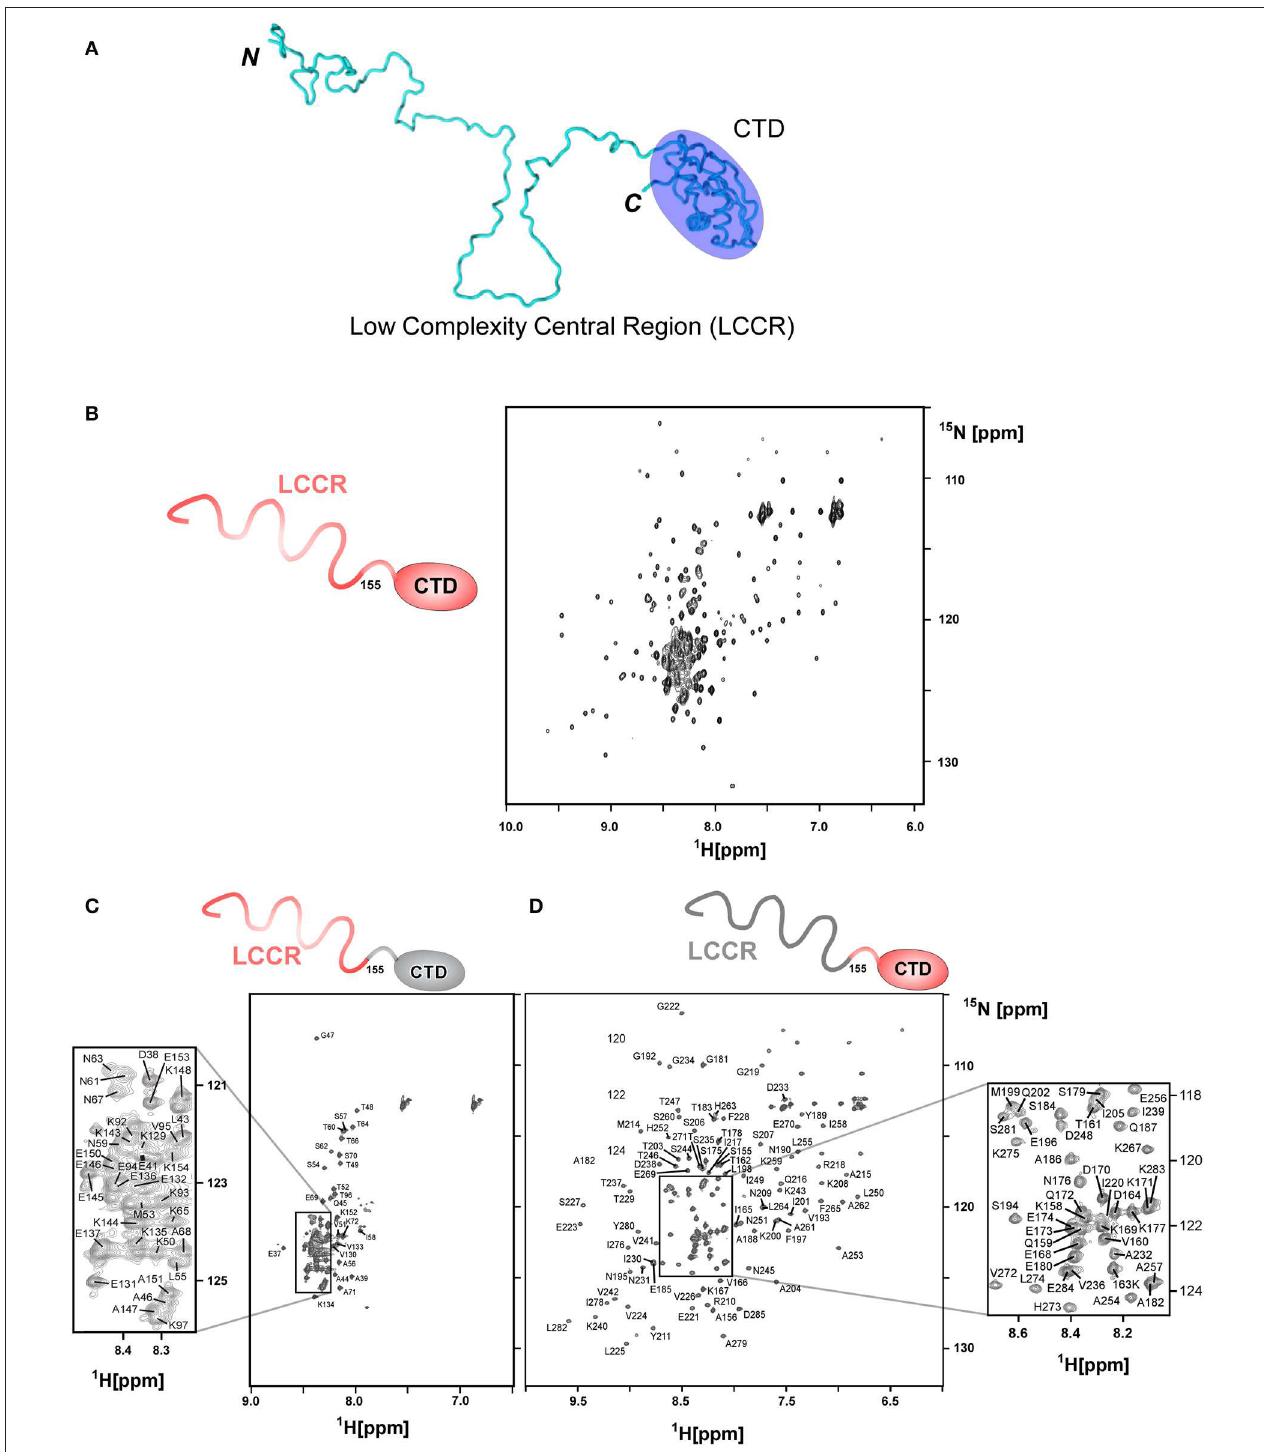
FIGURE 4 | Segmental labeling of Hp TonB (36–285) demonstrated by [ 1 H, 15 N]-HSQC spectra. (A) A cartoon model of Hp TonB (36–285), highlighting the globular CTD and the remaining proline-rich low complexity central region (LCCR). (B) [ 1 H, 15 N]-HSQC spectrum of the uniformly 15 N-labeled Hp TonB (36–285). (C) [ 1 H, 15 N]-HSQC spectrum of the segmentally 15 N-labeled LCCR (residues 36–154) of Hp TonB (36–285). (D) [ 1 H, 15 N]-HSQC spectrum of segmentally 15 N-labeled CTD (residues 155–285) of Hp TonB (36–285).